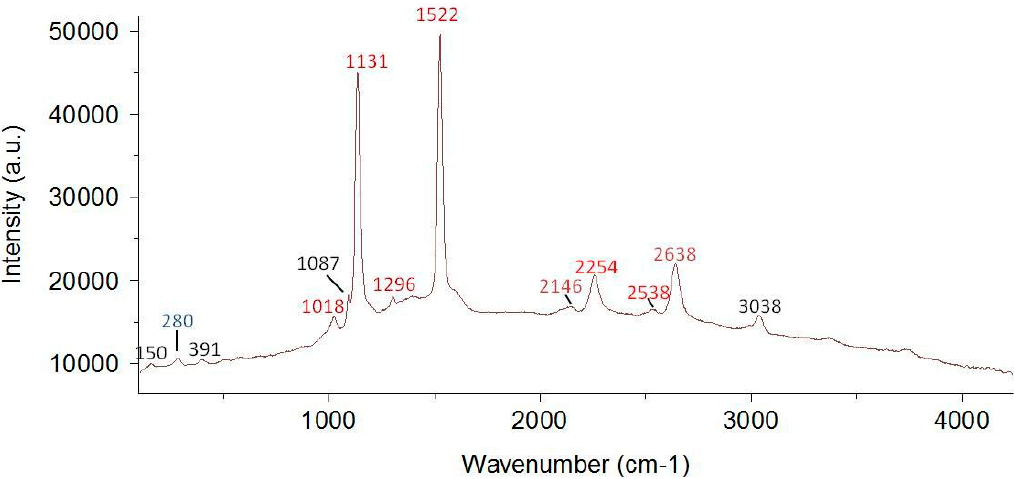
Figure 9. Ilvesheim “Weingärten”; Raman spectrum of the bow bead (see Figure 8). The characteristic ν 1 and ν 2 frequencies of the pigments at 1522 and 1131 cm − 1 are still very intense. Red = pigments; black = calcite.